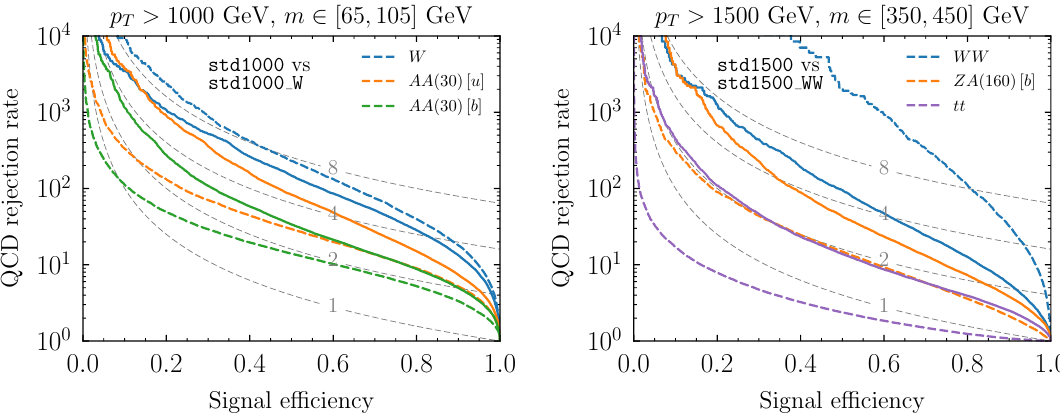
Figure 3 . Performance of dedicated taggers (dashed lines) compared to generic taggers (solid lines). Left: a dedicated W -tagger is tested on three signatures at the W -mass. Right: a dedicated 400 GeV WW -tagger is tested on three 400 GeV signatures.